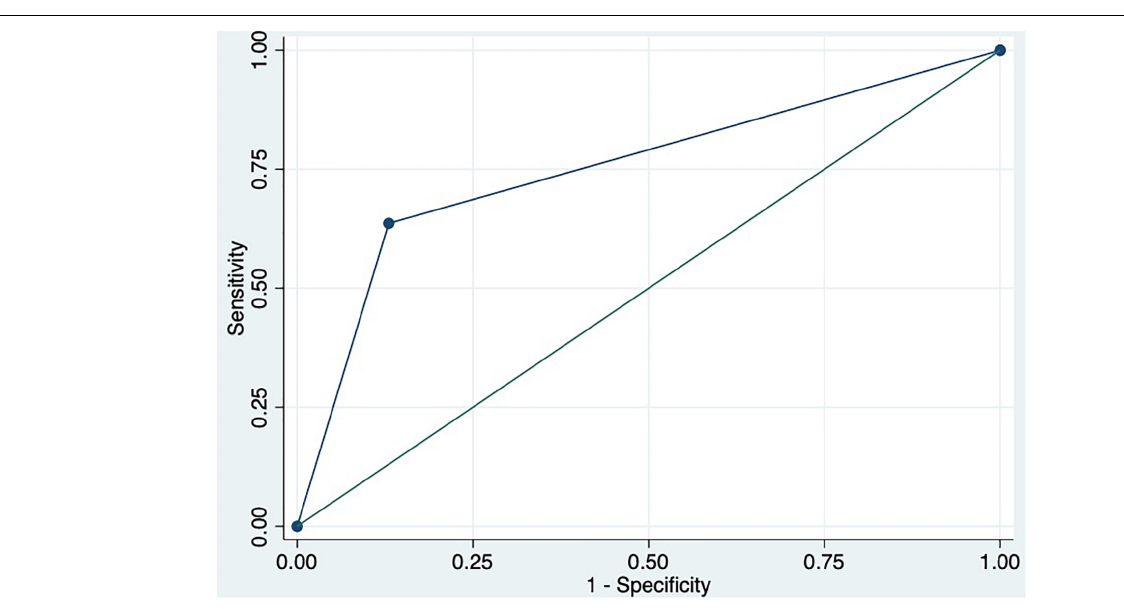
FIGURE 3 | ROC curve of the combination of spleen TE ≥ 74 KPa and damping index > 0.6 to predict acute response to